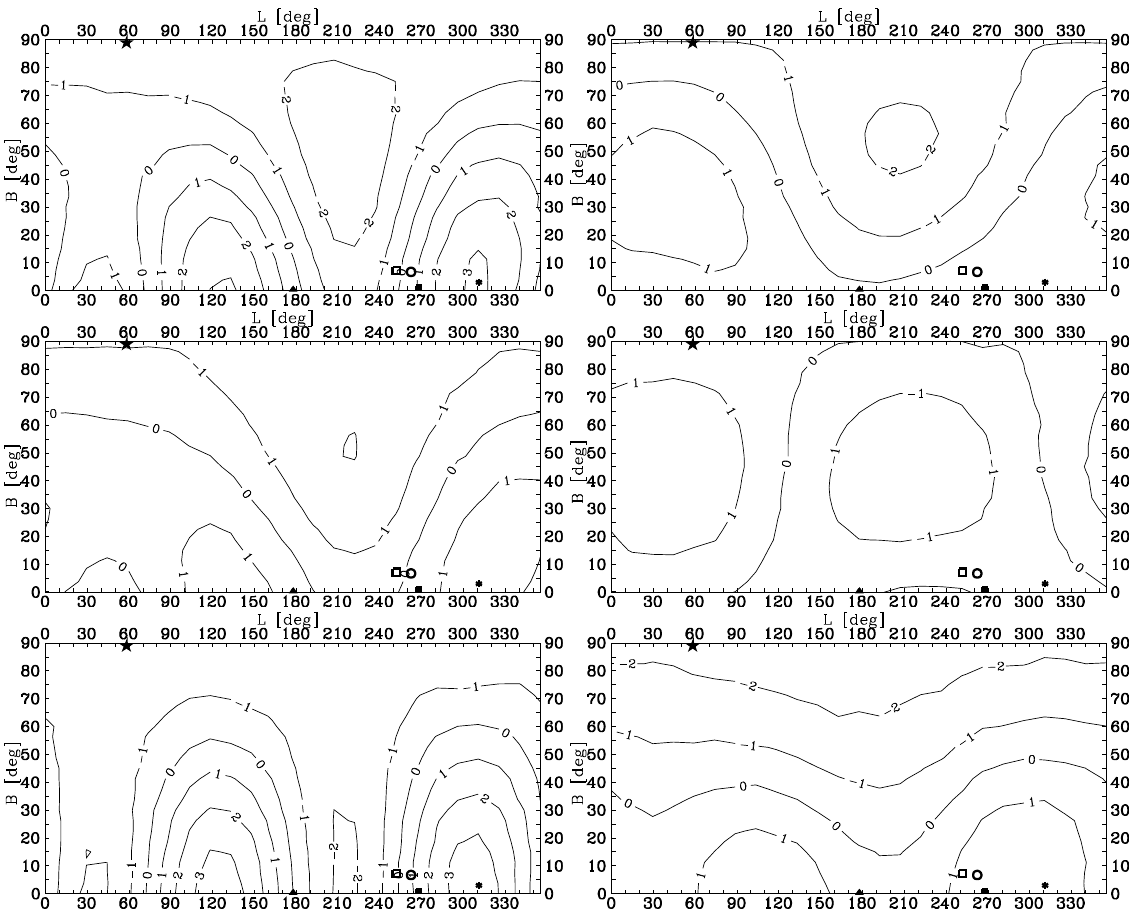
∆ ∆ Figure 11. Maps of s 11 / σ ( 11 ) versus the chosen cluster pole supergalactic co-ordinates ( L , ≡ B ) for the Cluster 12. In the maps, the results of the Tully data are shown on the left, while results obtained with help of HHD and FP corrections are given on the right. The maps are presented for all cluster galaxies (upper panel), as well as for spiral (middle panel) and non-spiral (bottom panel) sub-samples. In the map, we indicate the important directions, as seen from the center of the considered cluster: (1.) three cluster poles (full star, square and triangle), (2.) the direction to the Local Supercluster center (open circle), (3.) the direction of the Virgo A cluster center (open square) and (4.) the line-of-sight from the Earth (asterisk).